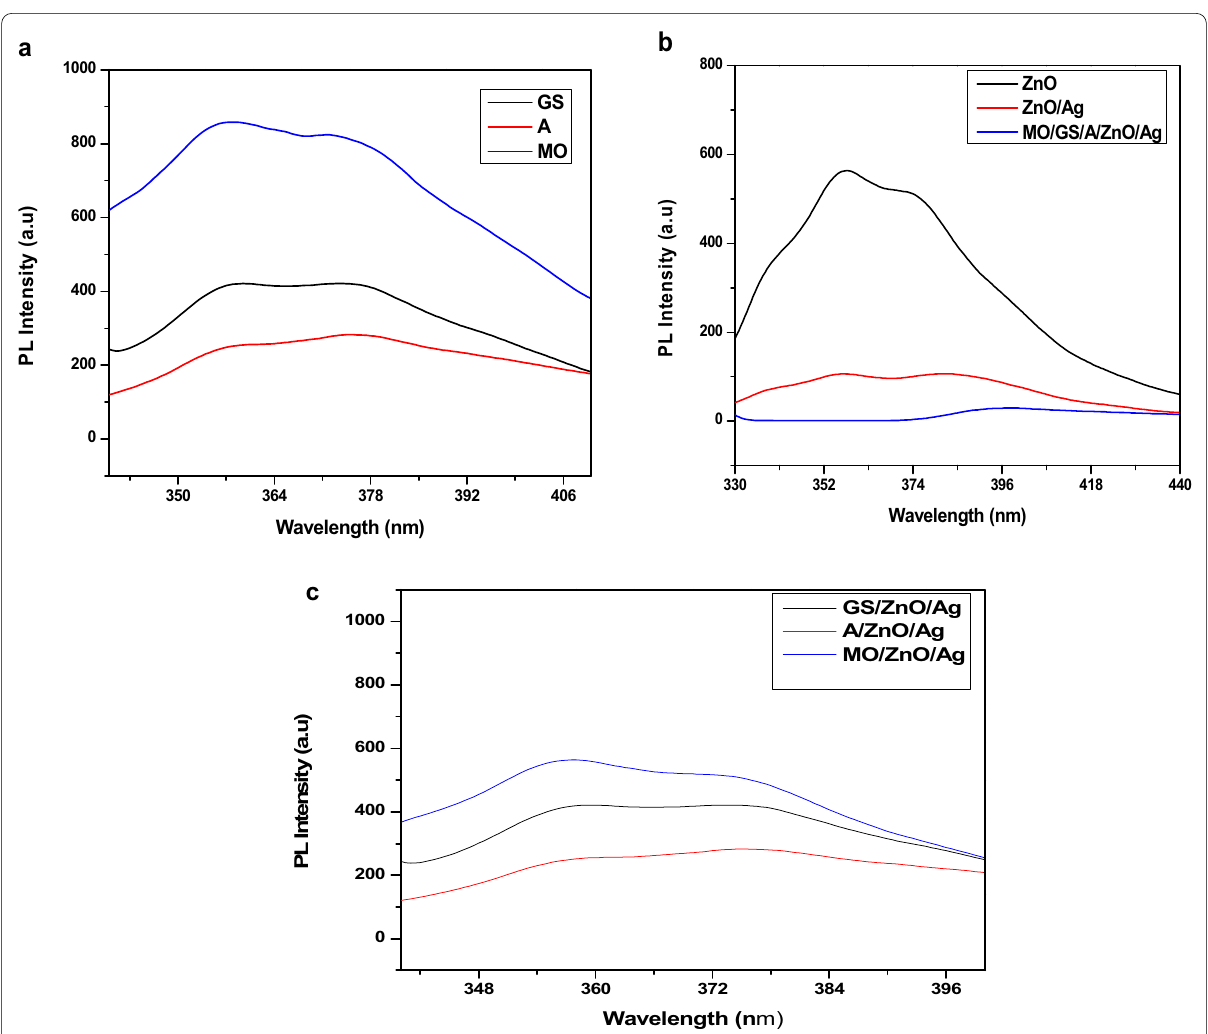
Fig. 4 Optical properties of the MO/GS/A/ZnO/Ag, MO/ZnO/Ag, GS/ZnO/Ag, A/ZnO/Ag heterogeneous photocatalyst and ZnO/Ag photocatalyst ( a ) PL of raw materials, b , c are PL of the synthesized